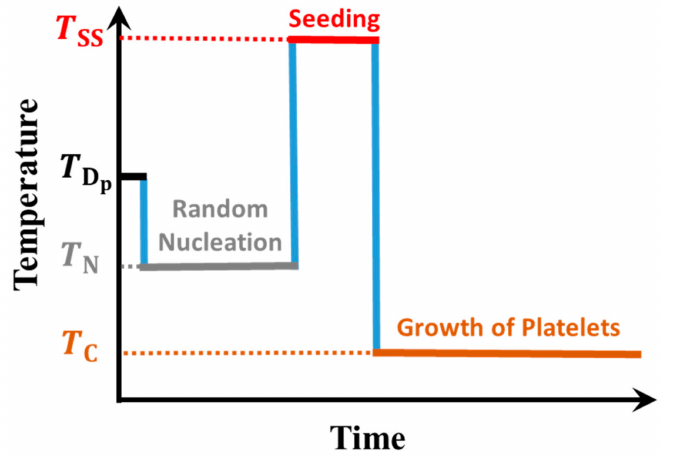
Figure 1. Thermal protocol used for crystallization of polymers in solution: Temperature defined the various stages of the polymer dispersion: partial dissolution (at T D rapid growth (at T N ), self-seeding (at T SS ) and slow growth of uniform PS- b -PEO platelets (at T C